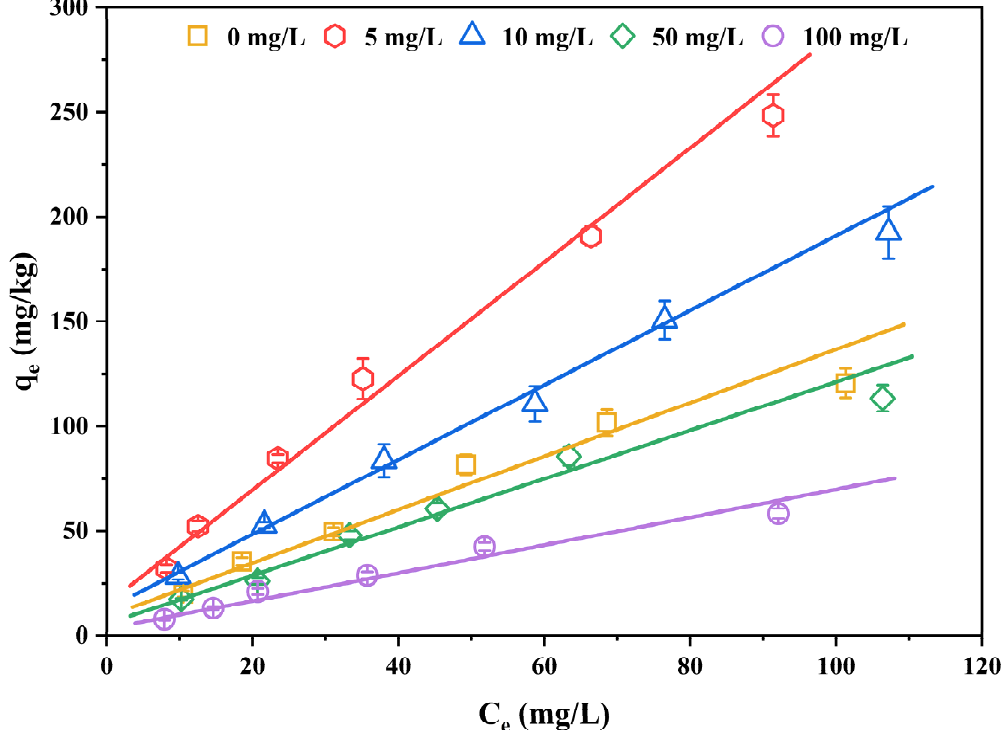
Figure 5. Isothermal sorption curves of 2,3,7,8-TCDT in the sediments of eastern Chaohu Lake under different DOM concentrations. Table 5. Freundlich model parameters of 2,3,7,8-TCDT in in sediments of eastern Chaohu Lake at different DOM